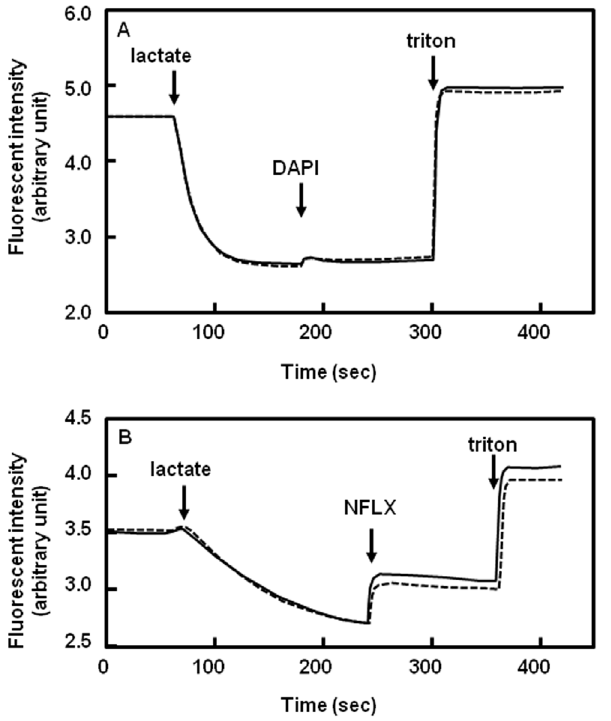
Figure 5. H + efflux assay in the inverted vesicle. H + efflux activity was tested with inverted membrane vesicles from E. coli KAM32/pHAP5 (solid line) and KAM32/pHY300PLK (dashed line). Each reagent was added at the time point shown by the arrow. The final concentration of lactate, potassium salt was 5 mM. Potassium lactate adjusted at pH 7.0 was used for the assay. The final concentrations of DAPI and NFLX were 5 m M and 250 m M, respectively, and the final concentration of triton X100 was 0.0125%. The assay mixture is 0.1 M Tricine-KOH (pH 8.0) containing 5 mM MgSO 4 (panel A). 0.1 M MOPS-KOH containing 5 mM MgSO